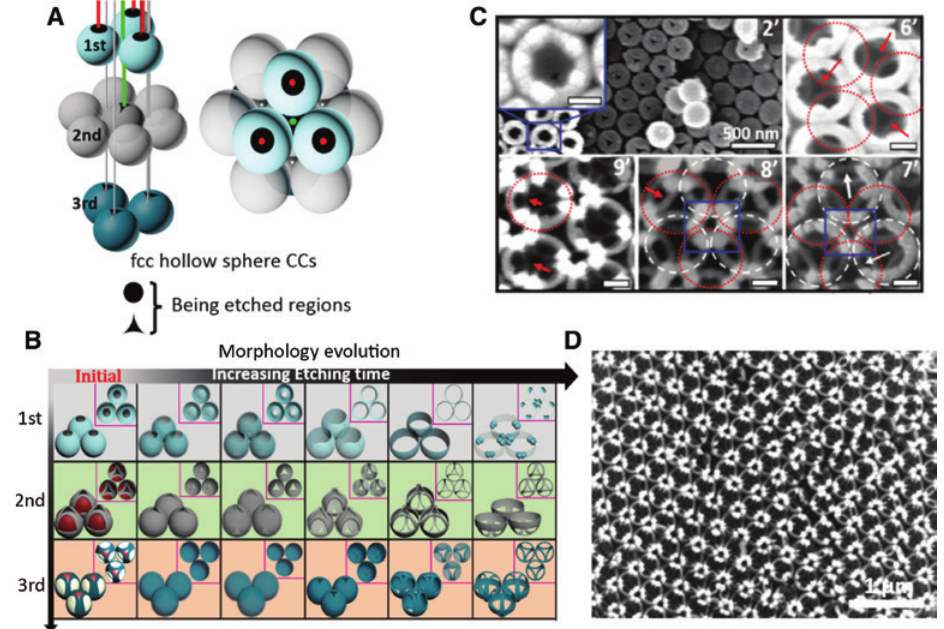
Figure 4: Direct fabrication of complex 3D hierarchical nanostructures based on hollow sphere CCs. (A) Schematic of an fcc unit cell to illustrate the formation mechanism of the 3D hierarchical nanostructures. Black areas in the left panel of the sphere represent the etching regions, and the lines with different colors represent reactive species vertical to the (111) plane of the crys- tals. The right panel is the corresponding top-view. (B) Schematic of proposed mechanism for the structural evolution in HSCCs, illustrated in a layer-by-layer manner (rows) for different etching times (columns). Column a represents the initial unetched state, where black, red, and white areas denote the regions, which will be etched in the process. The colors indicate which regions will be etched simultaneously depending on the (time-dependent) shadow effect from the upper layer spheres. (C) Typical SEM images of the HSCCs during the etching process. Intermediate times of t = 2, 6, 7, 8, and 9 min. White and red circles indicate the first- and the second-layer hollow spheres in CCs that are not yet visible or that are already etched away, respectively. The scale bars are 100 nm. (D) An SEM image of the final complex 3D hierarchical nanostructures. Adapted with permission from ref. [110], COPYRIGHT 2016 The Royal Society of